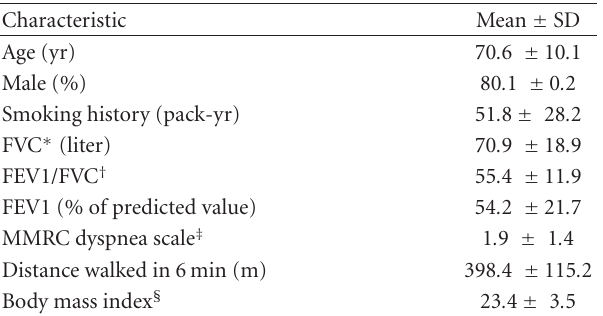
Table 2: GOLD stages of chronic obstructive pulmonary disease (COPD), BODE index score, and BODE quartiles in the 89 COPD